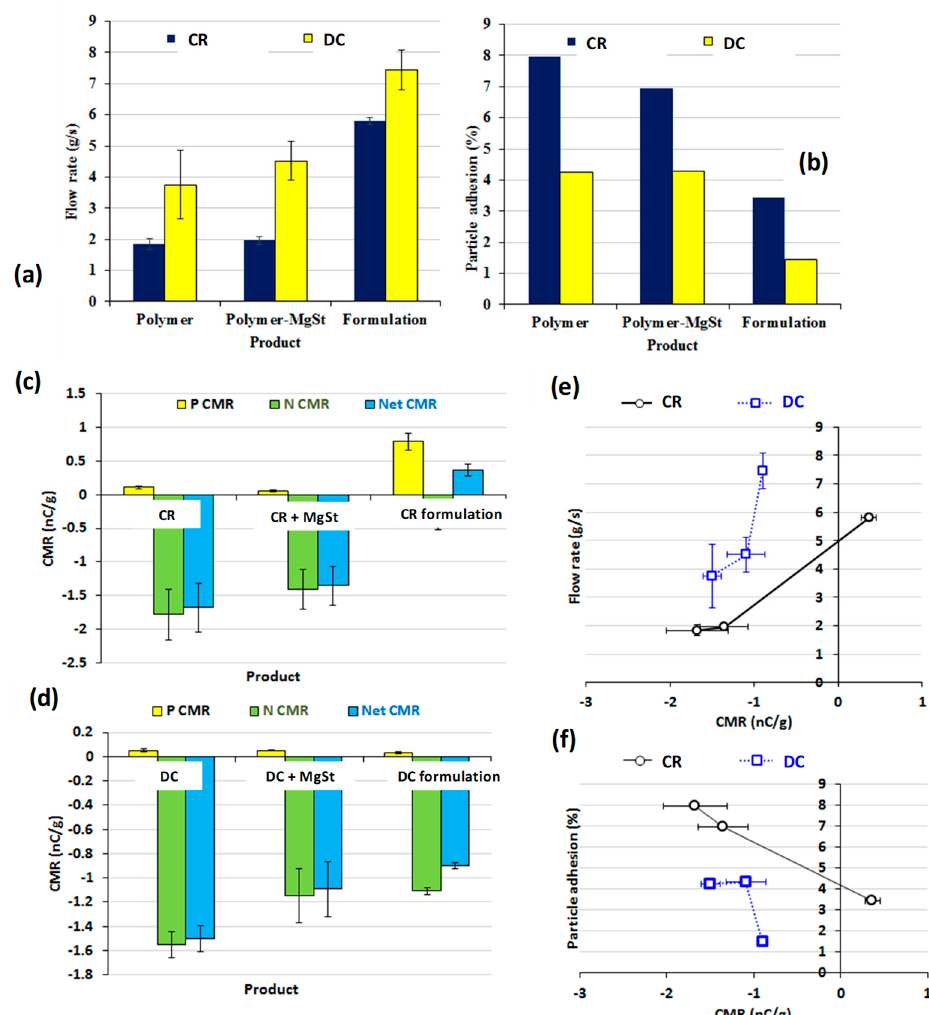
Figure 4. Powder flow rate (g / s, mean ± SD, n = 5) ( a ), % particle adhesion to stainless steel walls post flow rate analysis for powders under investigation ( b ), positive charge to mass ratio (P CMR), negative charge to mass ratio (N CMR) and net charge to mass ratio (Net CMR) of the CR material ( c ), positive charge to mass ratio (P CMR), negative charge to mass ratio (N CMR) and net charge to mass ratio (Net CMR) of the CR material ( d ), plot of the flow rate of CR and DC samples under investigation against the net-CMR ( e ) plot of the % particle adhesion of CR and DC samples under investigation against the net-CMR ( f ).